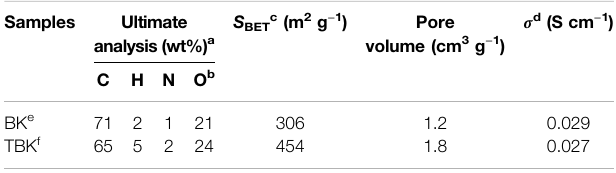
TABLE 2 | Properties of biocarbons from kraft pulps. Samples